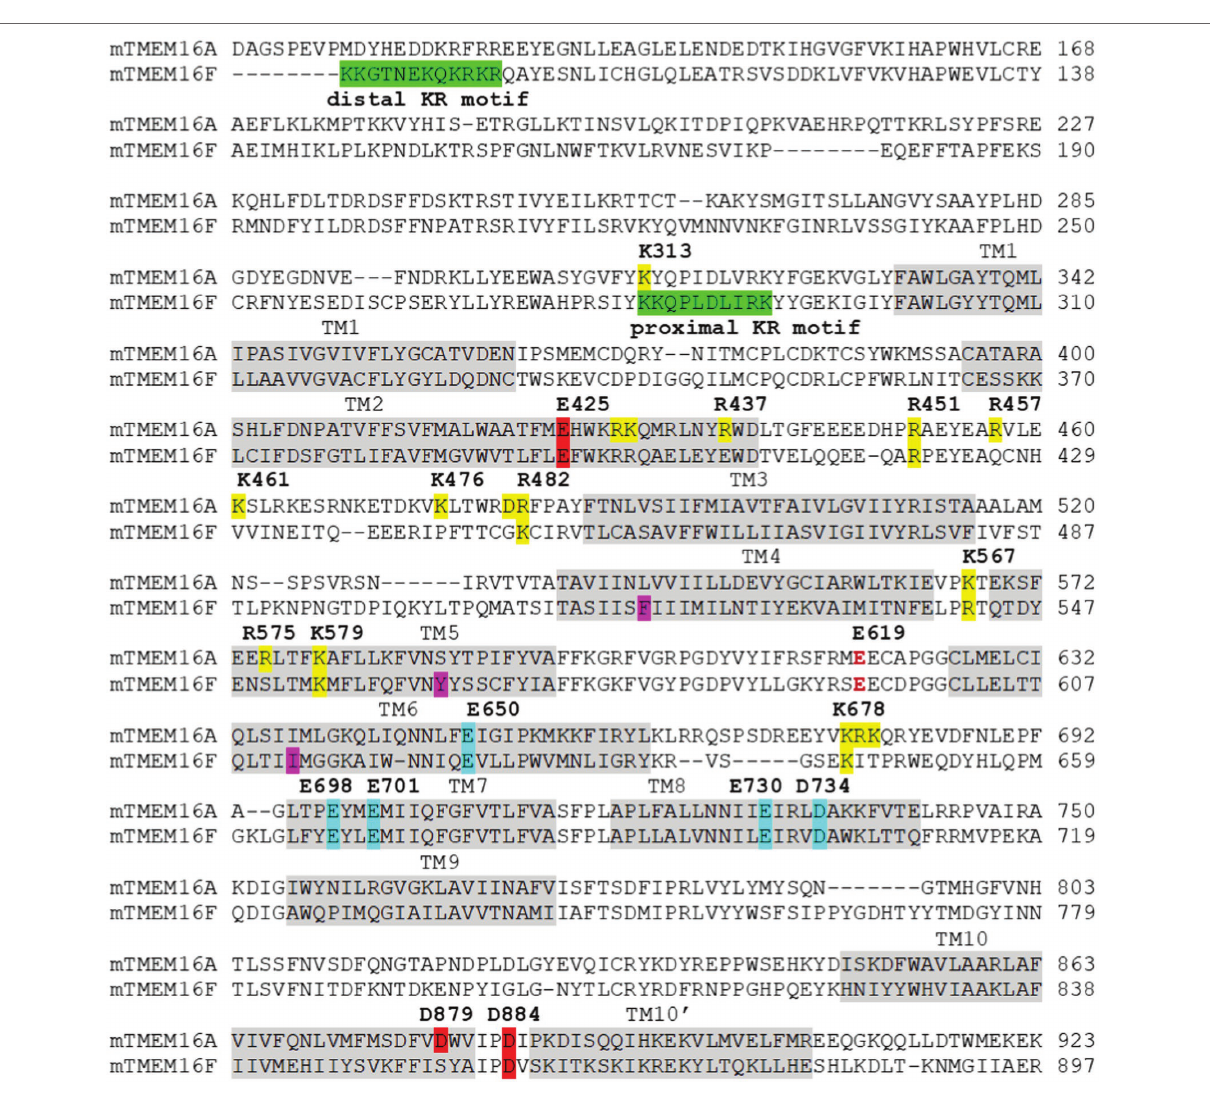
FIGURE 3 | Sequence alignment of the murine (m) TMEM16A (the “a” isoform) and TMEM16F. The transmembrane domains (TM) are highlighted in light gray. The distal and proximal motifs (Aoun et al., 2016; Ye et al., 2018) important for PI(4,5)P 2 binding in TMEM16F are highlighted in green. Residues that are important for PI(4,5)P 2 binding in TMEM16A (Le et al., 2019a; Yu et al., 2019; Ko et al., 2020) are highlighted in yellow. Residues at the third Ca 2+ site (Le and Yang, 2020) are highlighted in red, and residues forming the primary Ca 2+ sites are highlighted in cyan. Residues that form the inner gate (F518, Y563, and I612) in TMEM16F (Le et al., 2019b) are highlighted in magenta. Intracellular pH affects the primary Ca 2+ binding sites (cyan highlight; Chun et al., 2015; Liang and Yang, 2021) and extracellular pH works on a conserved glutamate residue (E619 in TMEM16A, dark red text; Cruz-Rangel et al.,